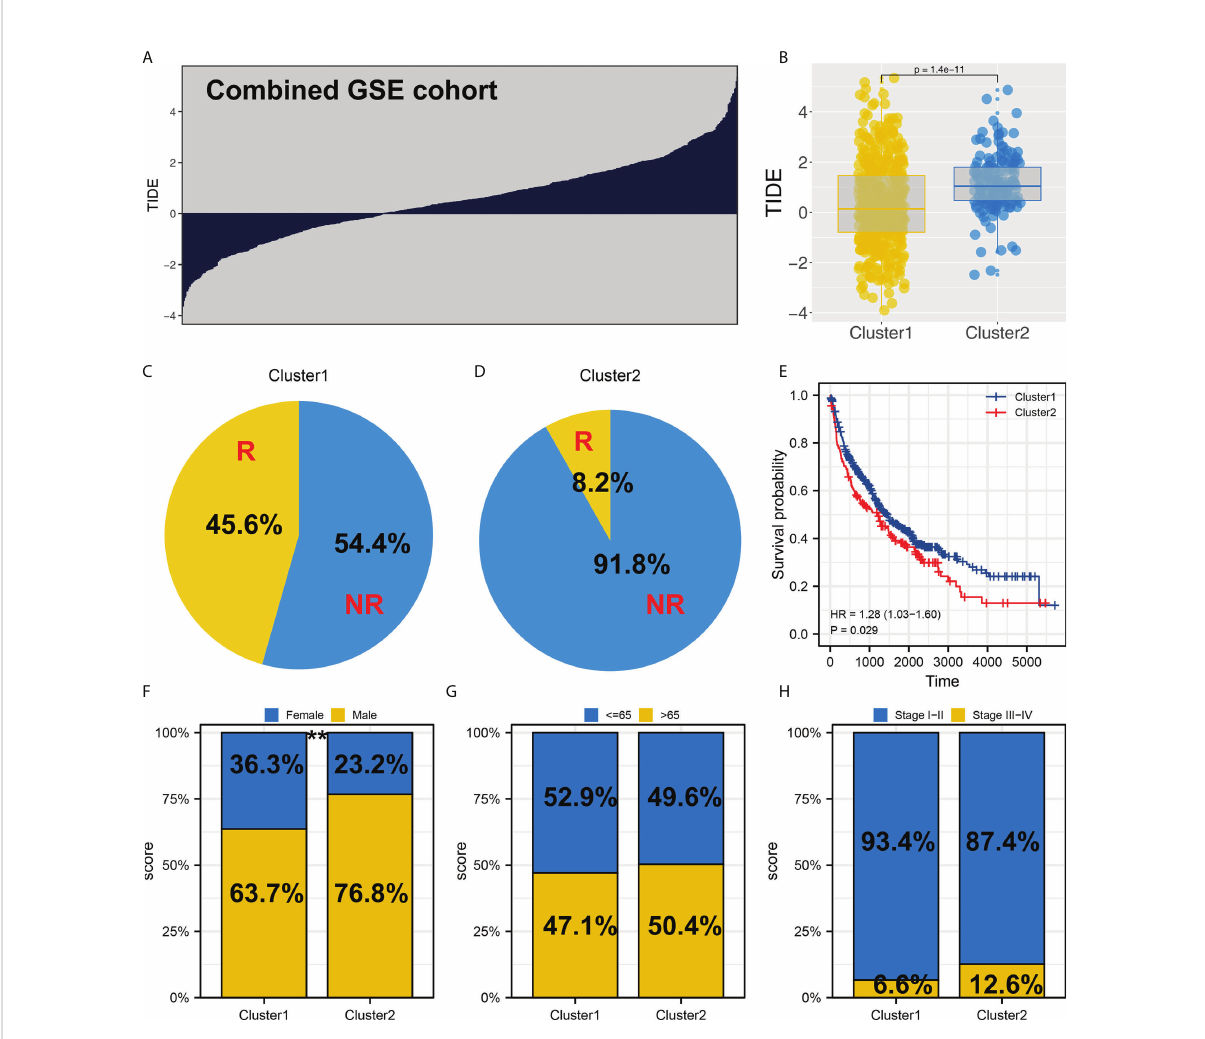
FIGURE 4 Validation in the GEO cohort. (A) TIDE analysis was performed in the combined GEO cohort; (B) Cluster2 had a higher TIDE score than Cluster1; (C, D) The proportion of immunotherapy responders in Cluster1 and Cluster2 patients; (E) KM survival curve of Cluster1 and Cluster2 patients in GEO cohort; (F-H) Clinical differences between Cluster1 and Cluster2, ** = P <